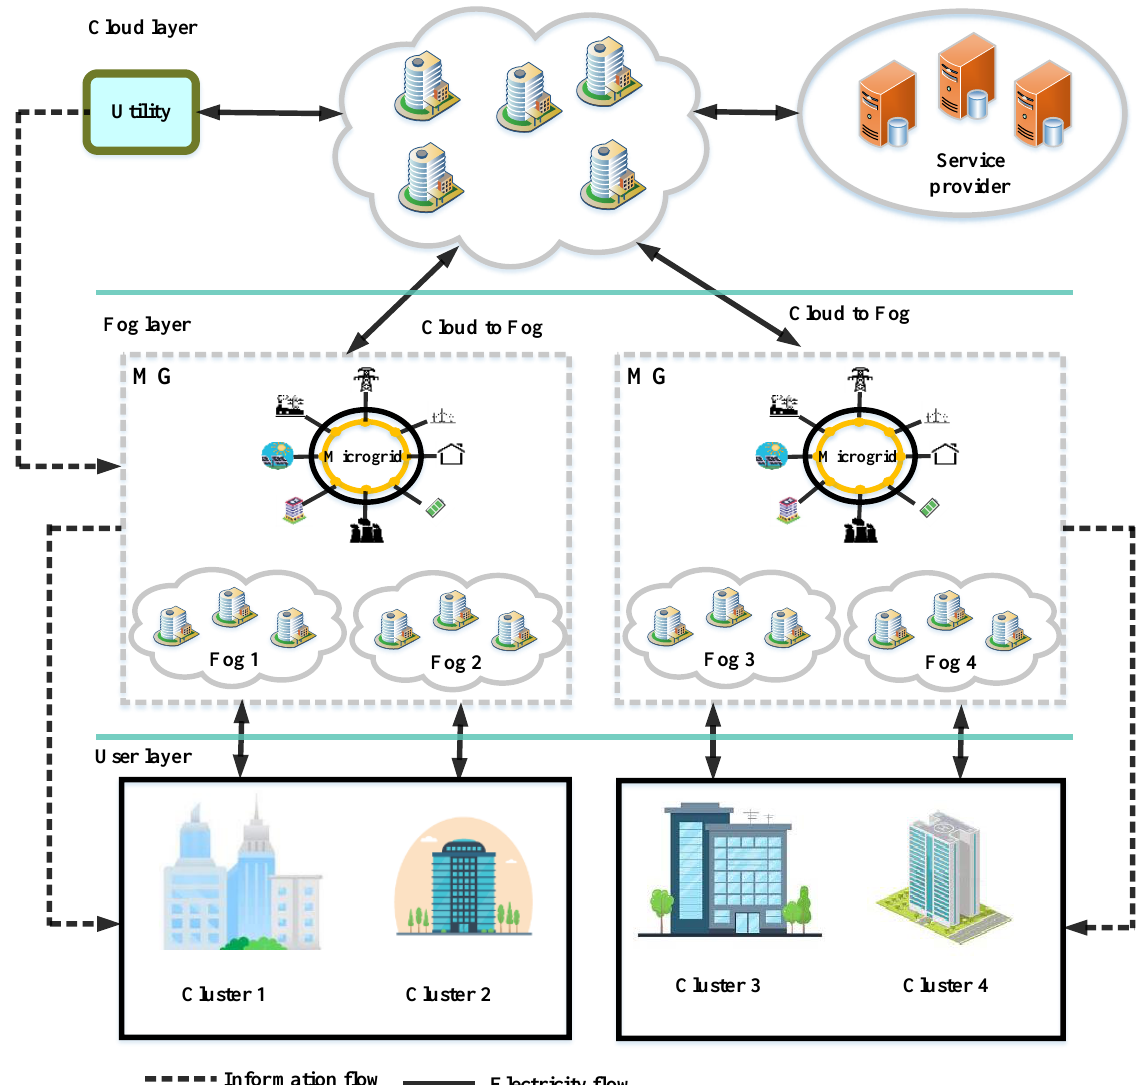
Figure 1. A representation of the suggested system scheme.